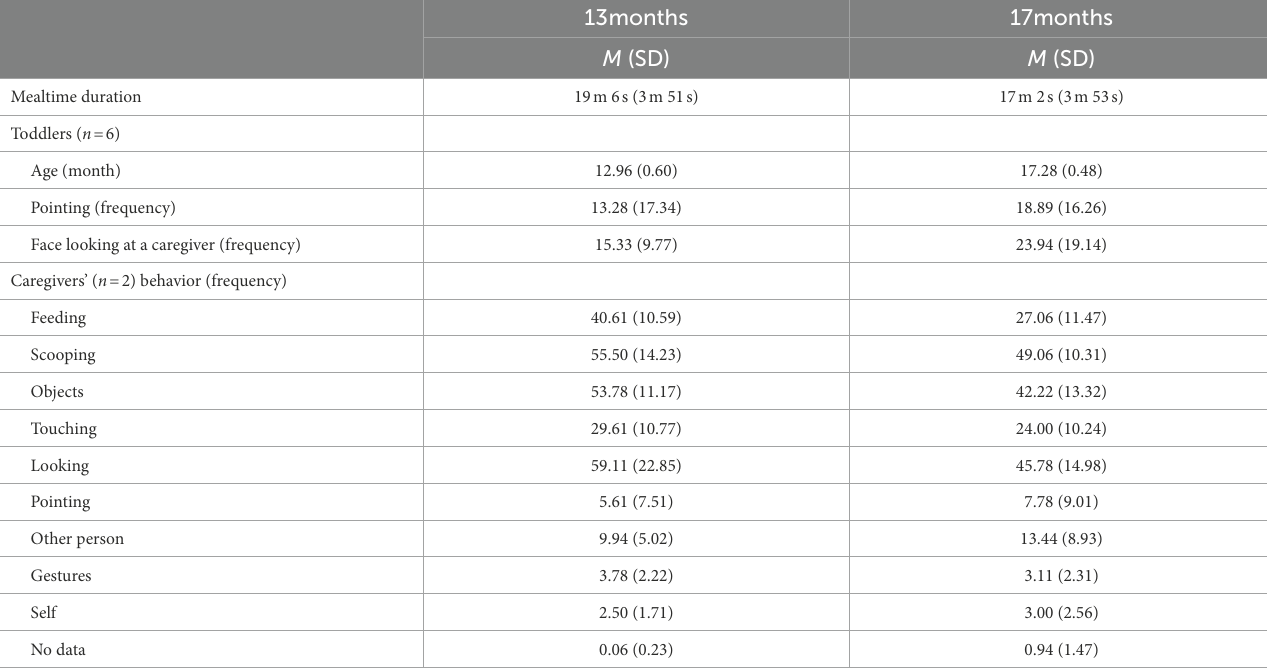
TABLE 1 Mean and standard deviation of meal time, age of the toddler, the frequencies of toddler’s pointing and face looking, and the ten categories of caregiver’s behavior observed within each meal when the toddler was 13 and 17 months old.